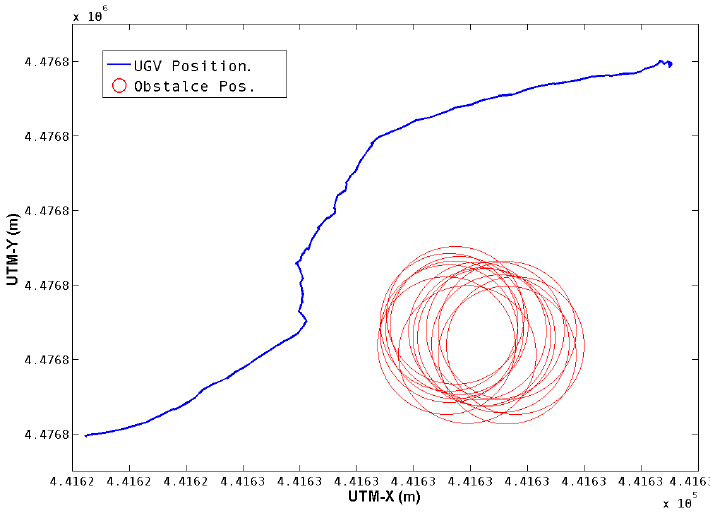
Figure 7. Single obstacle Avoidance. The trajectory of the UGV while performing the avoidance maneuver, and the detected obstacle positions are shown.